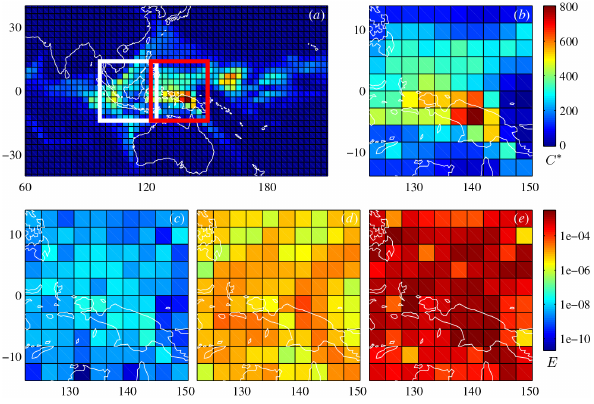
Figure 2. Comparison of sensitivities C ∗ for test case II. (a) Sen- sitivity calculated from a single run of RETRO-TOM by Eulerian backtracking. The white rectangle indicates the location of the re- ceptor region and the red rectangle illustrates the location of the source patch used in subsequent subplots. (b) The same sensitivity calculated directly from a 10 × 10 patch of TOMCAT forward runs. Results are indistinguishable from those shown in (a) . (c) Relative error of the Eulerian backtracking results in (a) in comparison to the (true) direct sensitivity in (b) . (d) As for (c) but with Eulerian backtracking performed without reversing the convective mass cor- rection. (e) As for (c) but with Eulerian backtracking performed by naive RETRO-TOM, that is without initializing the density field to agree with that in the forward problem. Note the logarithmic colour scale for the error plots.